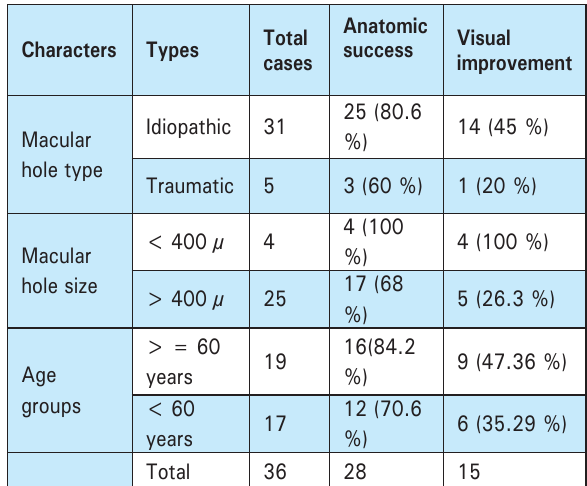
Table 7. Anatomic success and visual outcome at the last follow-up